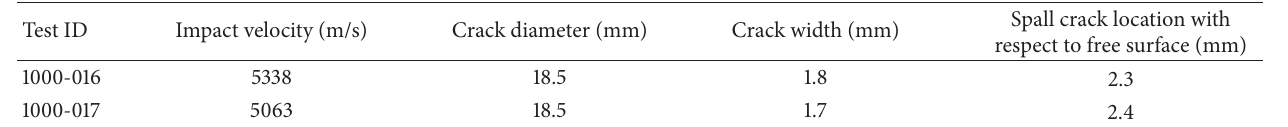
Table 2: Details of spall crack in sectioned plates.